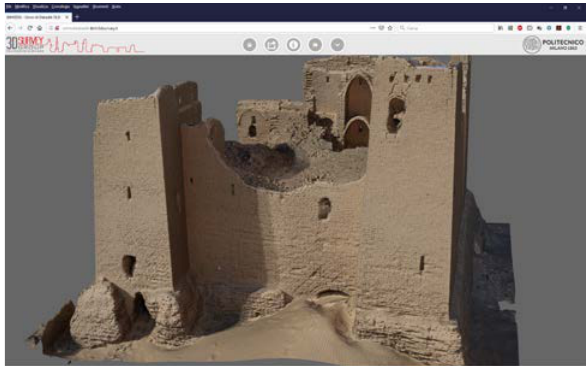
Figure 8: Forte of Umm al-Dabadib in Egypt on BIM3DSG